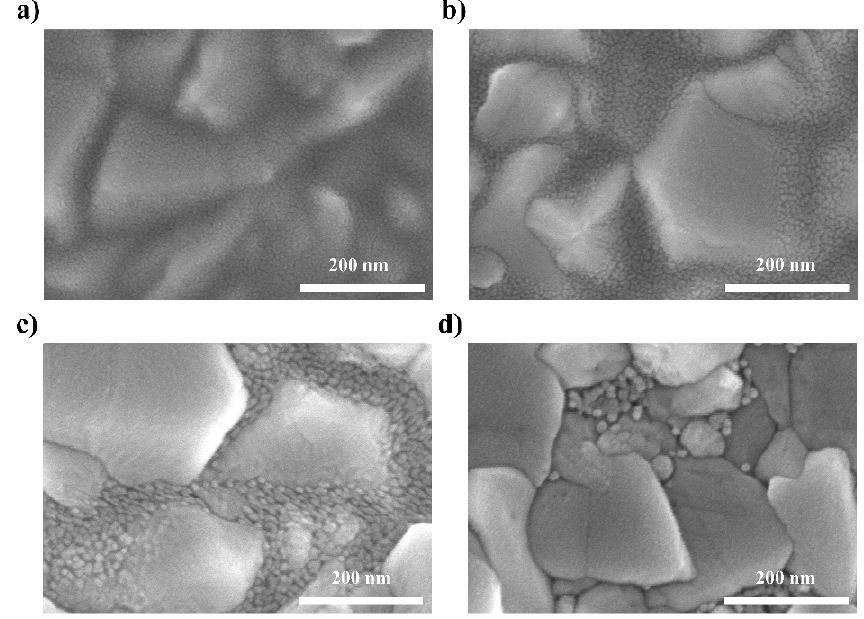
Figure 3. Top SEM image of SnO 2 layer after annealing at ( a ) 200, ( b ) 300, ( c ) 400, and ( d ) 500 °C on FTO glass.